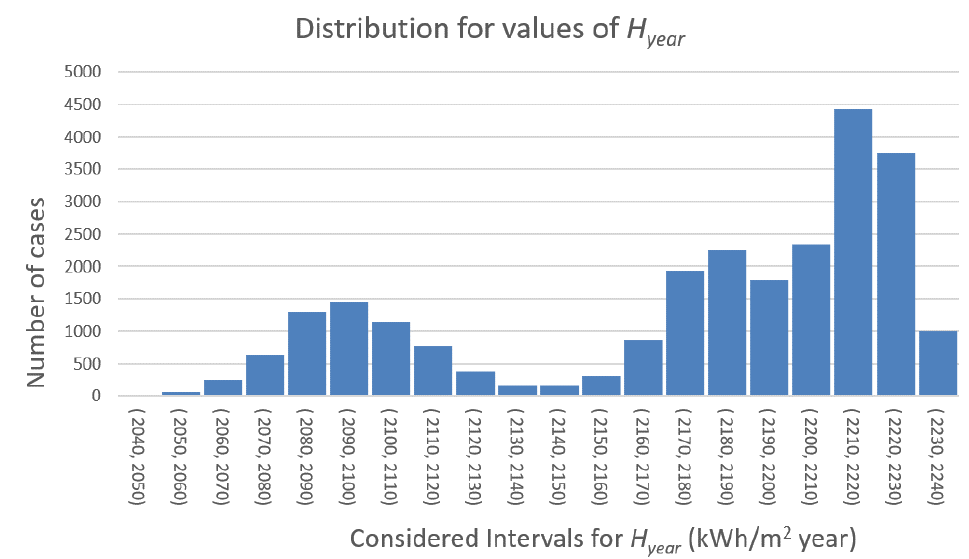
Figure 10. Distribution of annual solar radiation values ( H ) according to membership intervals.